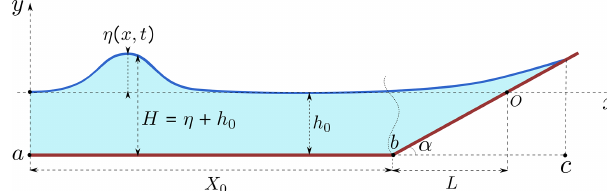
Figure 1. Bathymetry sketch. The wavy curve at the toe of the slope regards analytical solution, which does not take into account merg- ing between the constant depth and sloping beach